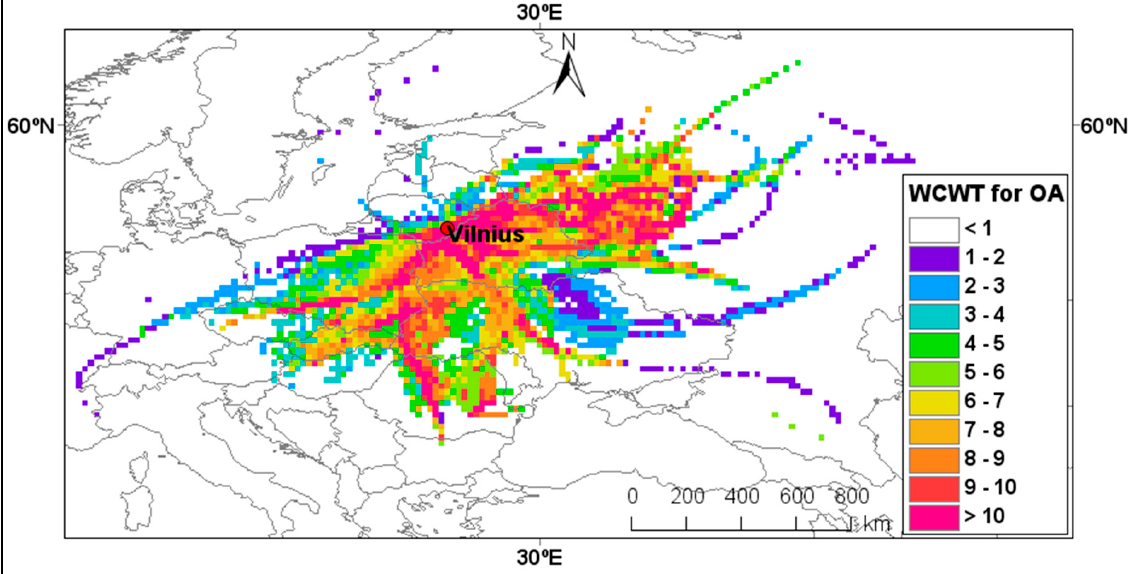
Figure 12. Weighted concentration weighted trajectory (WCWT) of OA in Vilnius in January and February 2014.